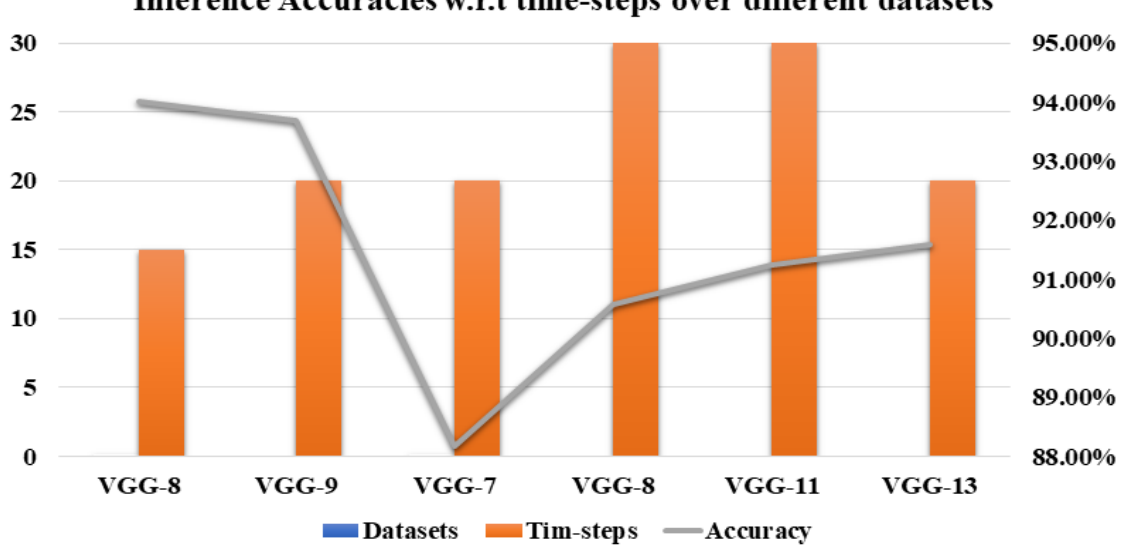
Figure 12. Classfication Performance w.r.t time-steps over CIFAR-10 and SVHN dataset.